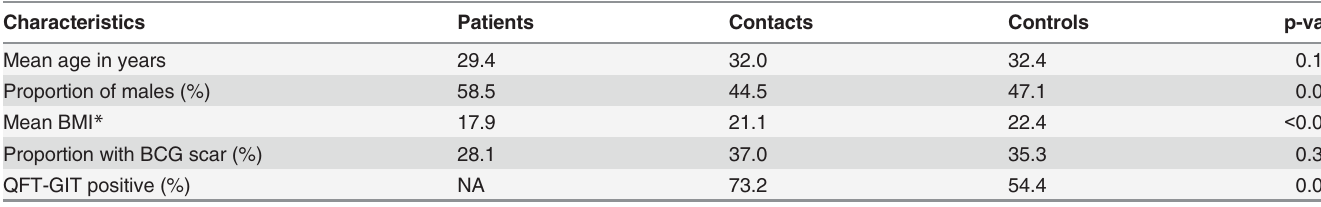
Table 1. Socio-demographic characteristics of study participants.